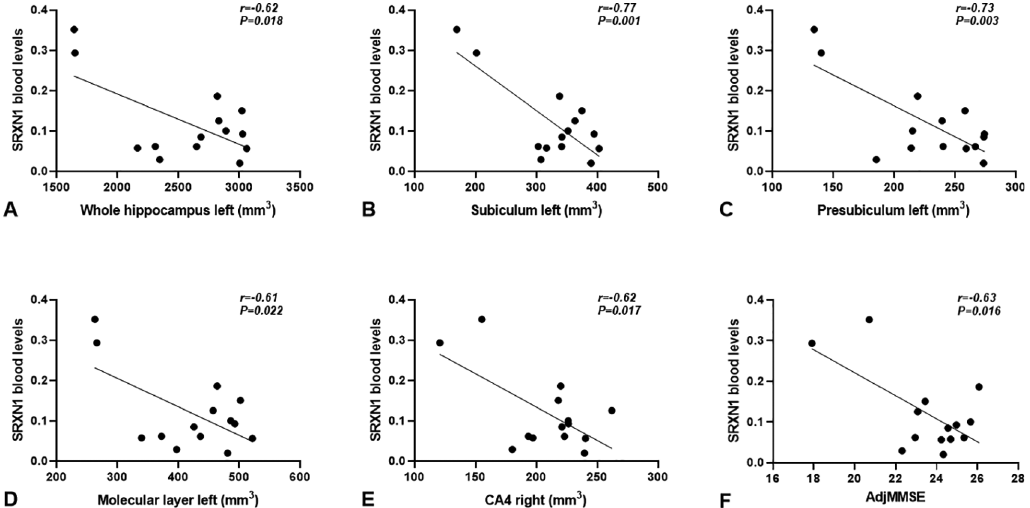
Figure 4. Correlations between blood SRXN1 mRNA levels and hippocampal subfields volume, (A) whole hippocampus left; (B) subiculum left; (C) presubiculum left; (D) molecular layer left: (E) CA4 right, and (F) adjMMSE in CD individuals. SRXN1 levels are expressed as 2 - Δ CT